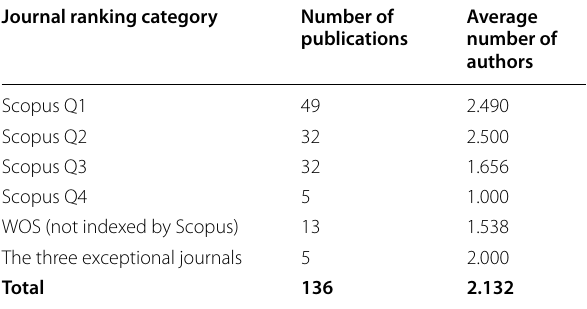
Table 5 Distribution of articles by journal ranking